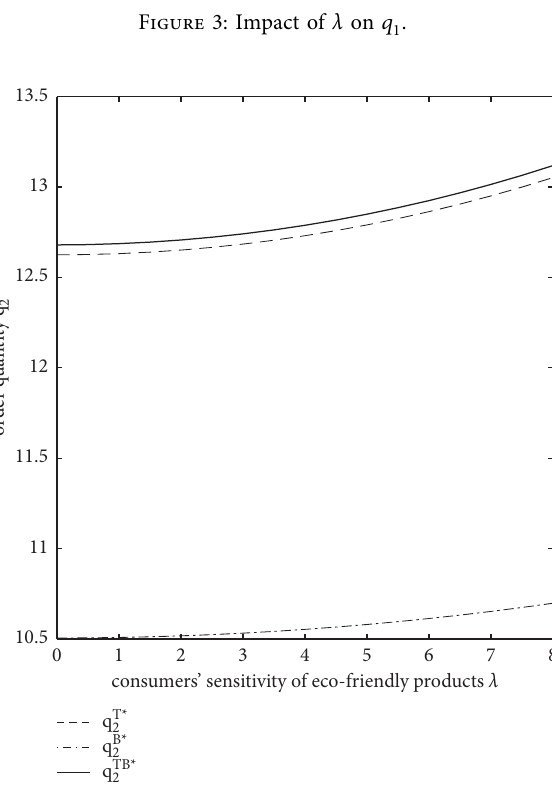
Figure 1: Impact of λ on w